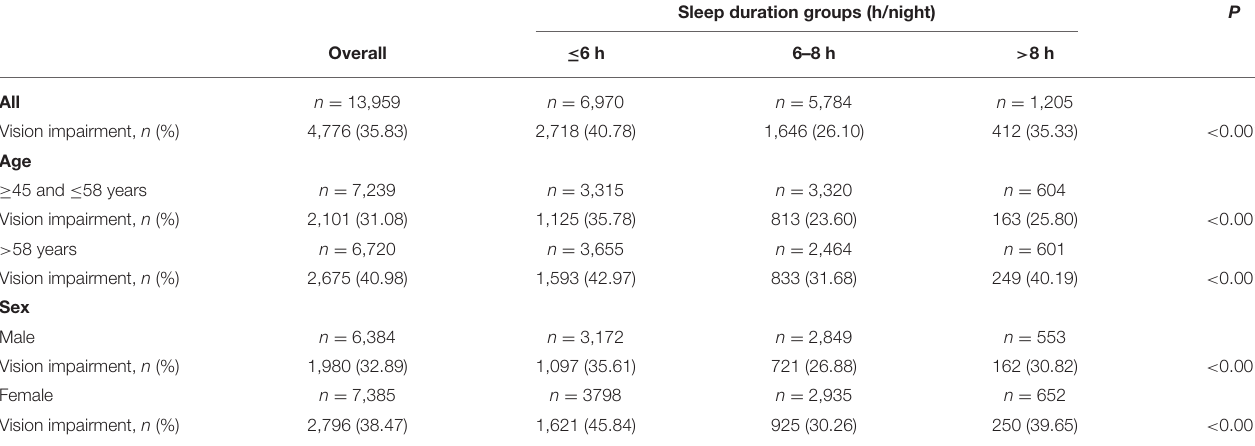
Sleep duration groups